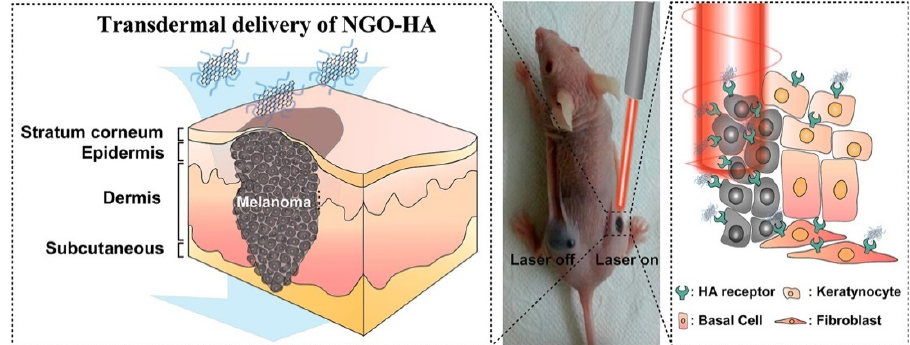
Figure 5. Schematic illustration for the transdermal delivery of nanographene oxide–hyaluronic acid (NGO–HA) conjugates into melanoma skin cancer cells and the following photothermal ablation therapy using a near-infrared laser. (Adapted with permission from Ref. [131]. 2014, Jung et al. More details on “Copyright and Licensing” are available via the following link: https://www.mdpi.com/ethics#10 (accessed on 10 October